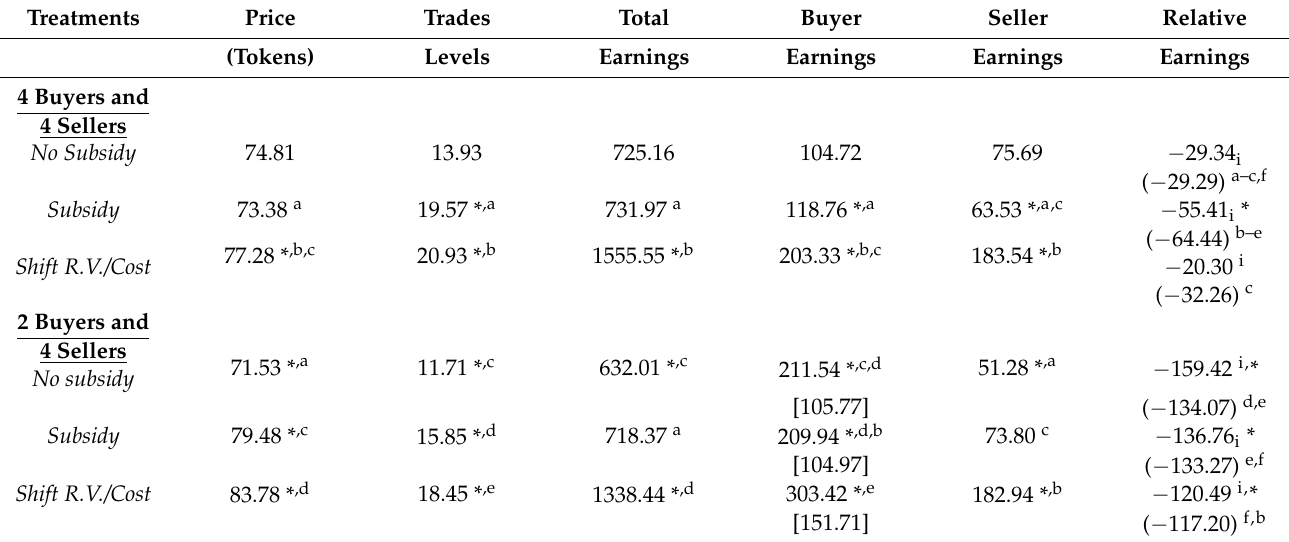
Table 2. Estimated convergence levels and treatment parameters for market